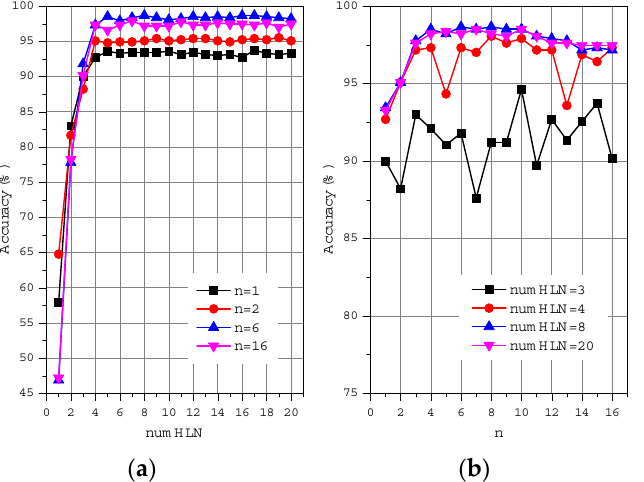
Figure 4. The impact of numHLN and n on recognition accuracy. ( a ) Accuracy varies with numHLN, ( b ) Accuracy varies with first order n.